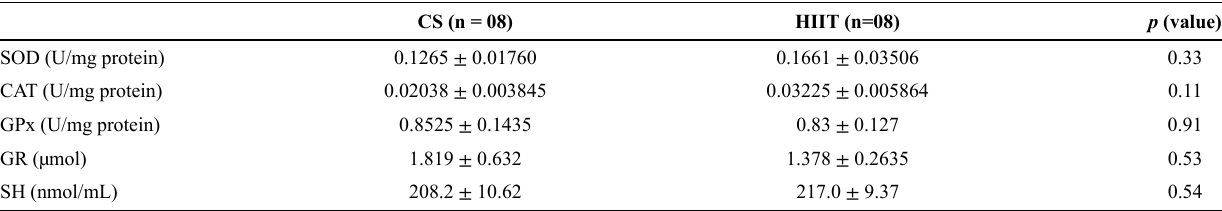
Table 2 - Effects of high intensity interval training for 12 days on enzymatic antioxidant activity superoxide dismutase (SOD), catalase (CAT), glu- tathione peroxidase (GPx) and glutathione reductase (GR), and non-enzymatic total sulfhydryl (SH) in cardiac tissues from rats. CS (n = 08) SOD (U/mg